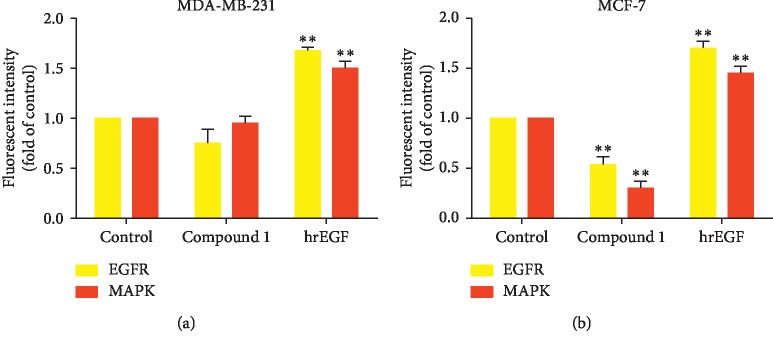
Inhibition of the EGFR/MAPK pathway after compound 1 treatment in MDA-MB-231 and MCF-7 cells. MDA-MB-231 and MCF-7 cells were incubated with compound 1 at IC0 and IC50 for 4 hours, and human recombinant EGF (hrEGF) was used as a positive control. Bar graphs of fluorescence intensity of EGFR and MAPK in MDA-MB-231 cells (a) and MCF-7 cells (b) were compared with the control (as folds) shown by using Guava® Flow Cytometry easyCyte™ Systems. The statistical significance values compared to the control (without treatment) are marked with asterisks, ∗∗p < 0.01.